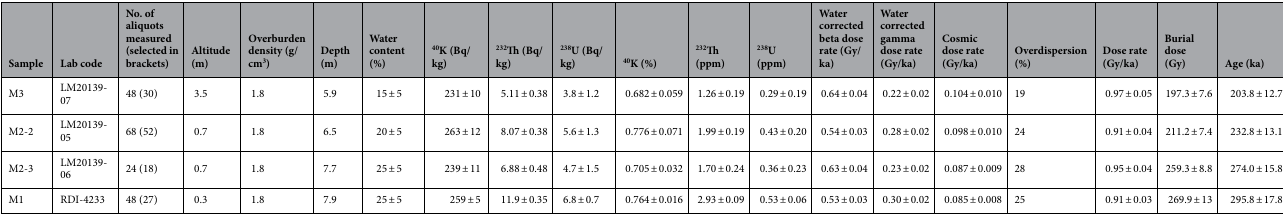
Table 2. Summary of the results and parameters used for OSL dating. Lab codes from the Centro Nacional de Investigación sobre la Evolución Humana—CENIEH (LM) and University of Seville (RDI) laboratories are also